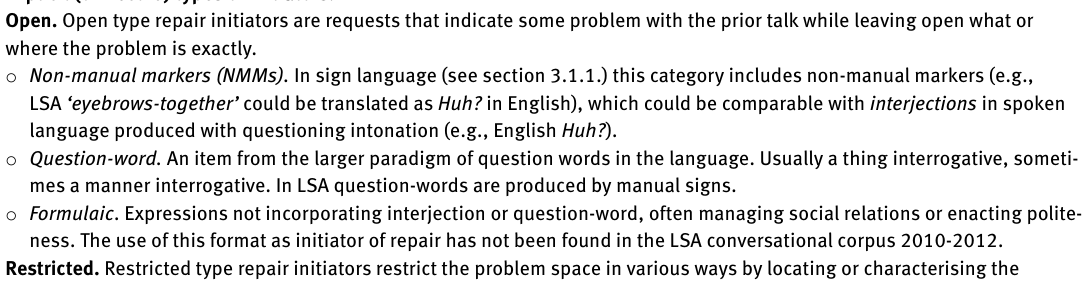
Table 2: Some basic format types for other-initiation of repair Explicit (on-record) types of